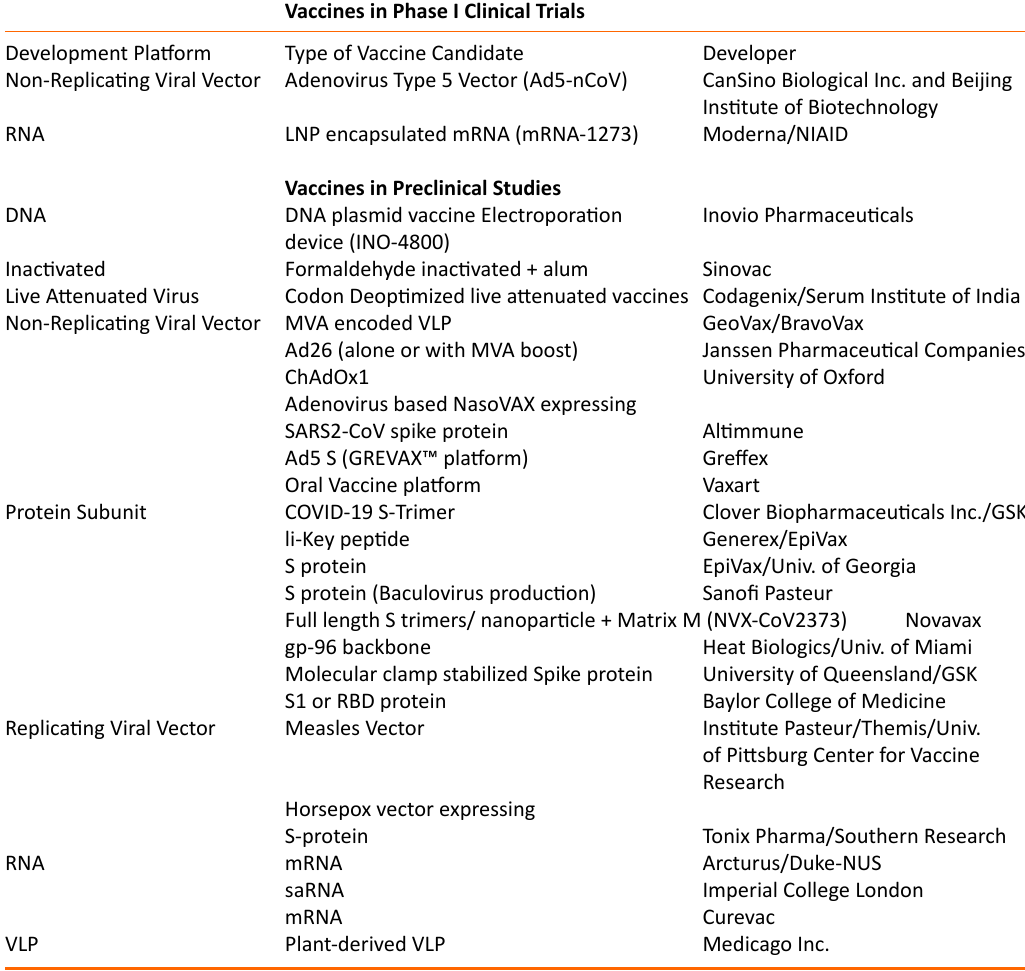
Table 1. Status of few candidate vaccines for COVID-19 under Development (Modified from WHO, 2020 35